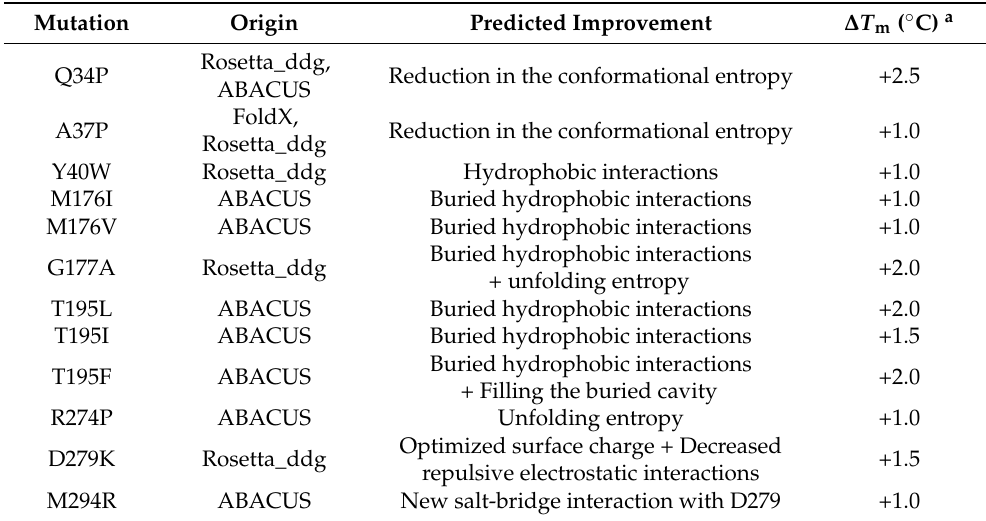
Table 1. Predicted structural basis and stabilizing effect of the beneficial mutations.